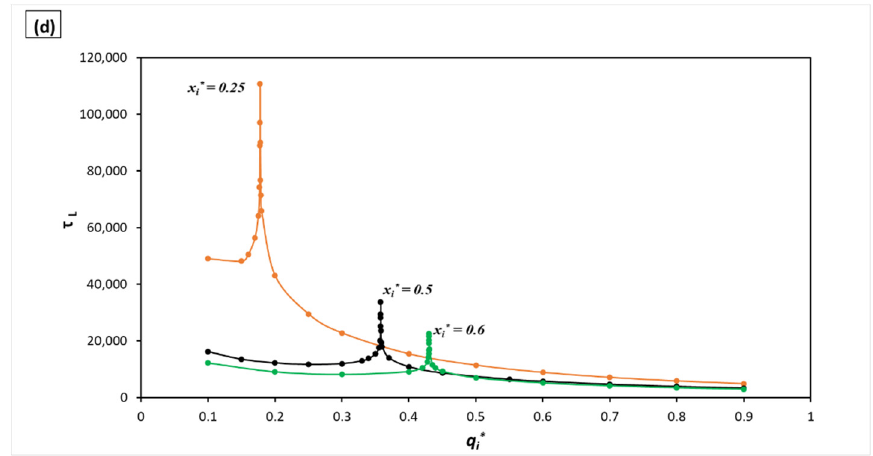
Figure 3. Effectiveness and average mixing entropy as a function of increasing 𝑥 (cid:3036)∗ ( a ), and 𝑞 (cid:3036)∗ ( b ). Corresponding period of the large ‐ scale oscillation, 𝜏 (cid:3013) (as shown in Figure 2) of energy transfer be ‐ tween the mechanical and electrical domains for increasing 𝑥 (cid:3036)∗ ( c ), and 𝑞 (cid:3036)∗ ( d ).